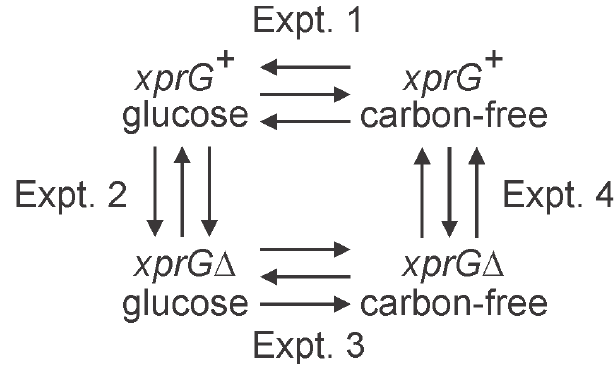
Figure 1. Design of the microarray experiments. The arrowheads point to the samples labeled with Alexa Fluor ® 555. Each experiment consisted of three biological replicates, indicated by arrows, and included a dye swap. The full genotypes of the xprG + (MH2) and xprG D (MK422) strains are given in Table